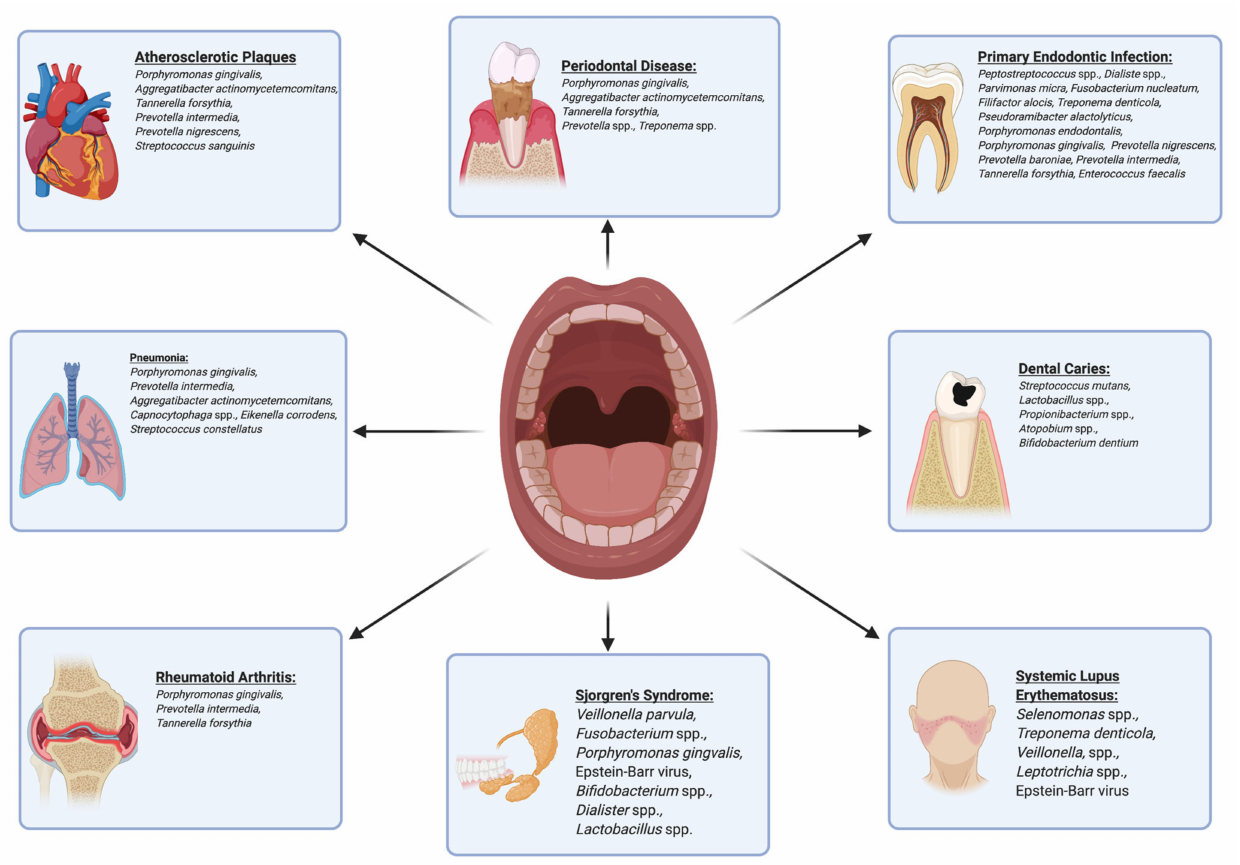
Figure 1. Oral bacteria are linked to numerous oral and systemic diseases, highlighting the importance of oral microbial homeostasis in the maintenance of health and prevention of